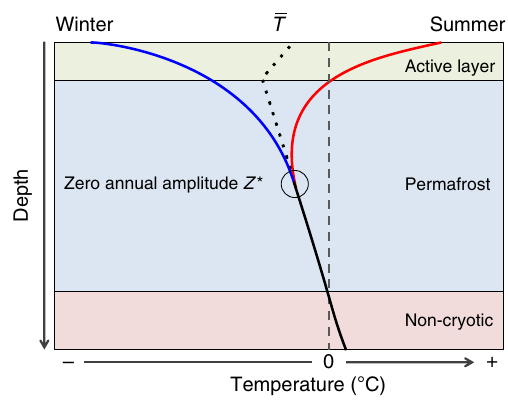
Fig. 7 Thermal regime of permafrost. Schematic showing the maximum (red line) and minimum ground temperature (blue line) during the year, and their convergence to give the mean annual ground temperature (cid:1) T at the depth of zero annual amplitude Z * . Black dots show the schematic mean temperature for permafrost soils. Compiled guided by French